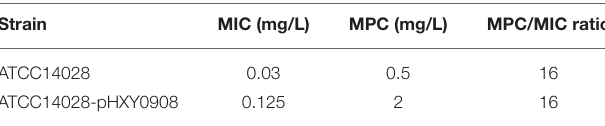
TABLE 1 | Ciprofloxacin MICs and MPCs of the Salmonella Typhimurium strains used in this